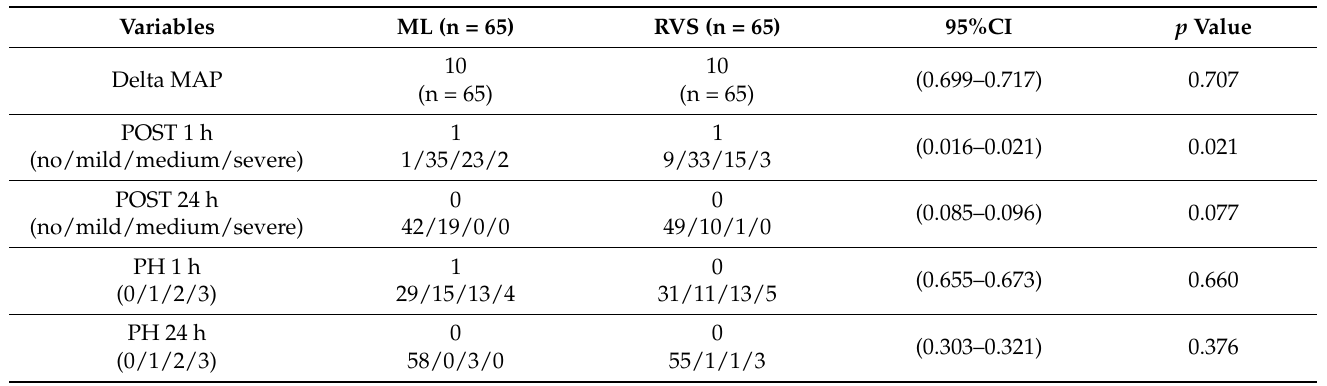
Table 3. Instant and later intubation